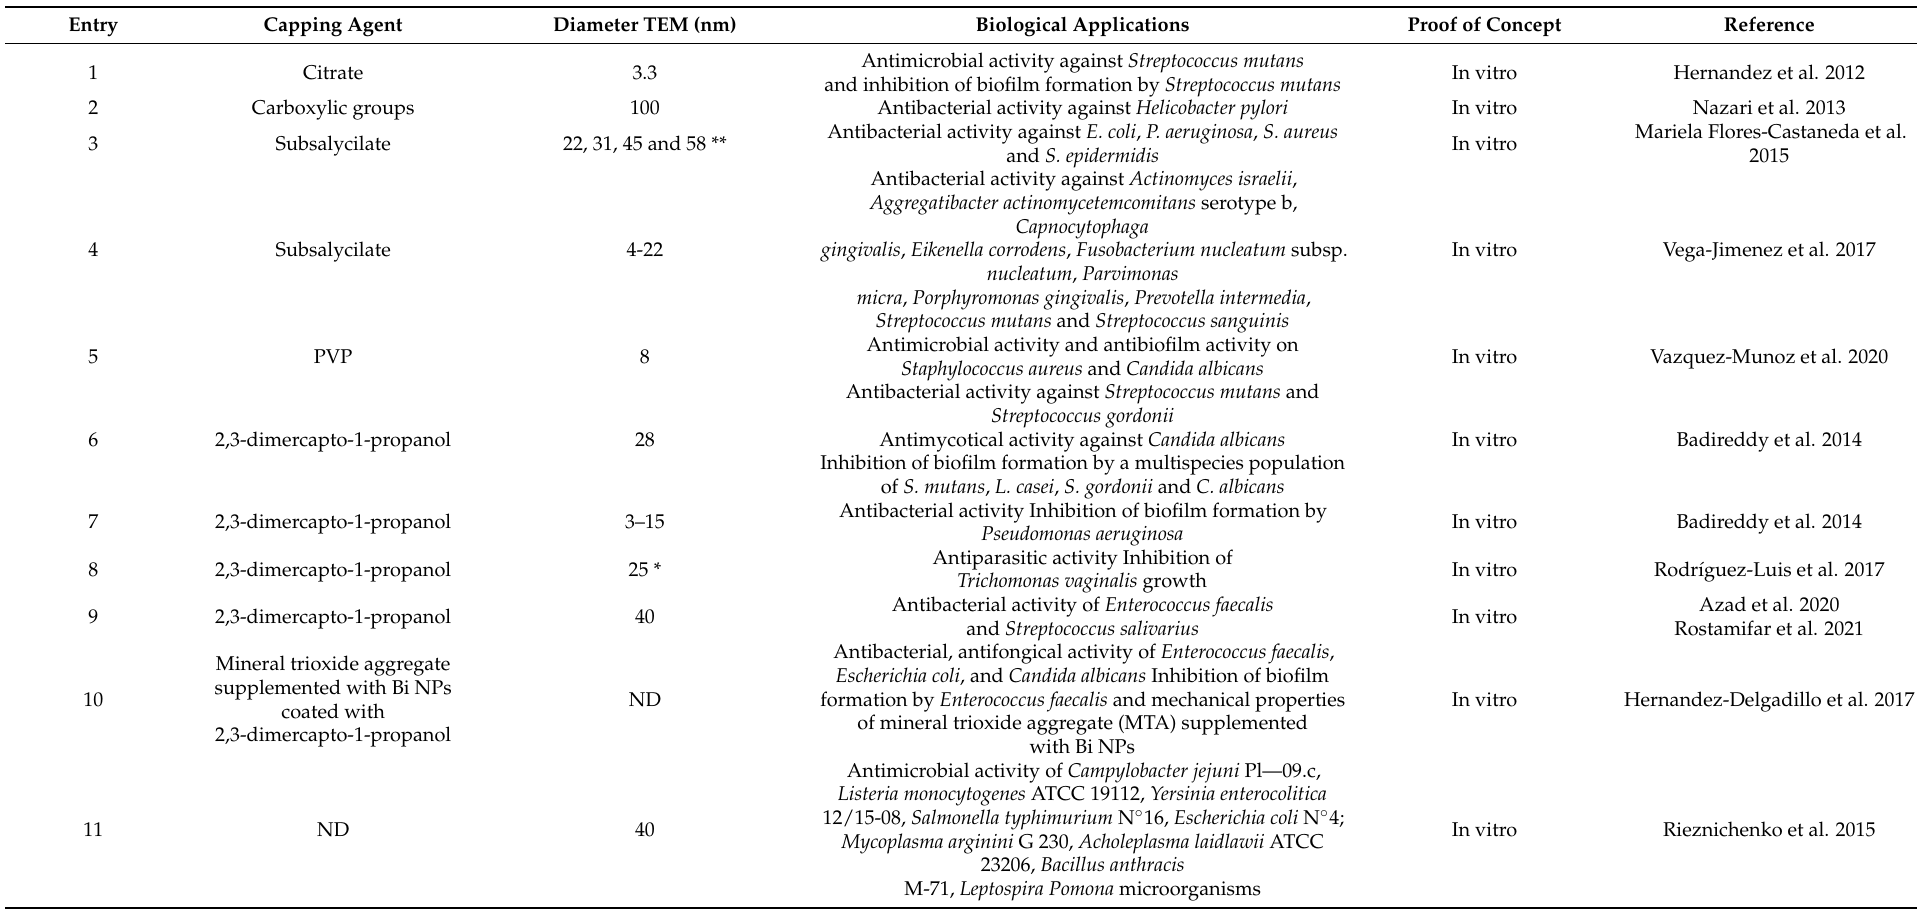
Table 2. Metallic bismuth nanoparticles as bactericidal, fungicidal, antiparasitic and antibiofilm